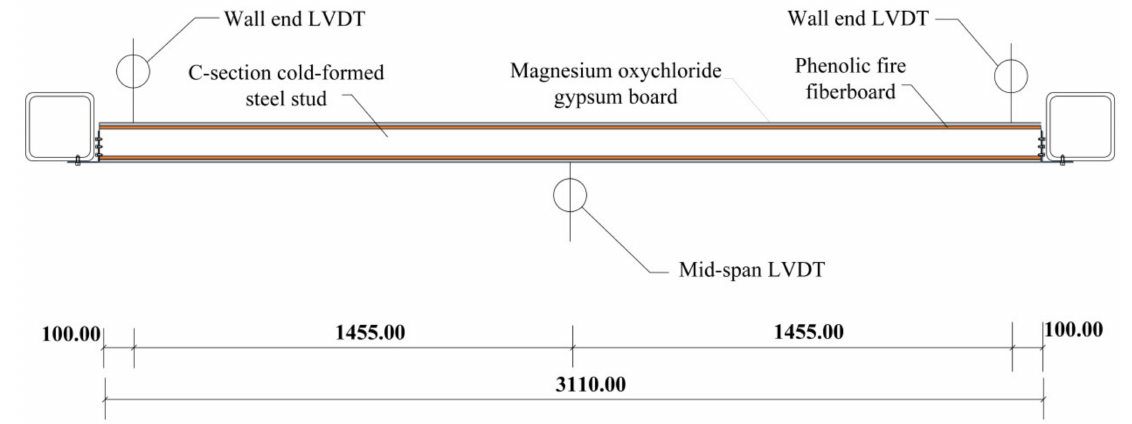
Figure 7. Overall arrangement of specimen linear displacement sensors (mm).